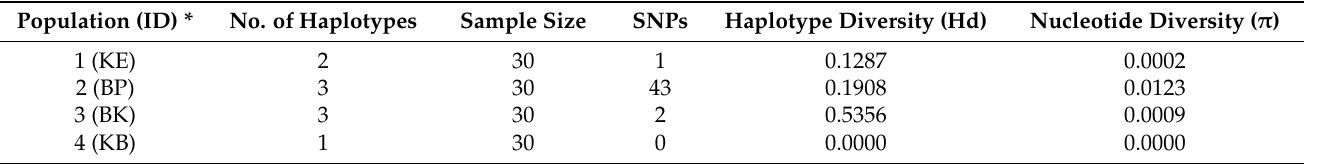
Table 2. Sample size, number of haplotypes, number of single-nucleotide polymorphisms, haplotype diversity, and nucleotide diversity of different sites of Batagur affinis .